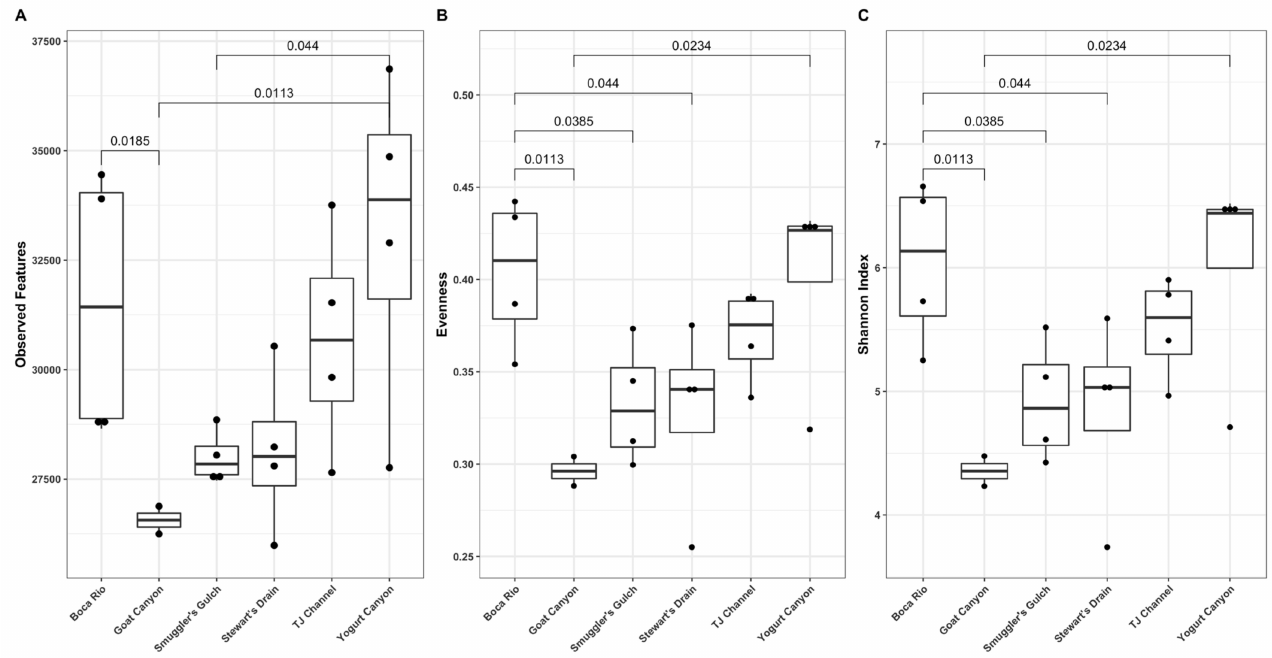
Figure 3. Alpha diversity metrics across sites based on observed features ( A ), evenness ( B ), and Shannon Index ( C